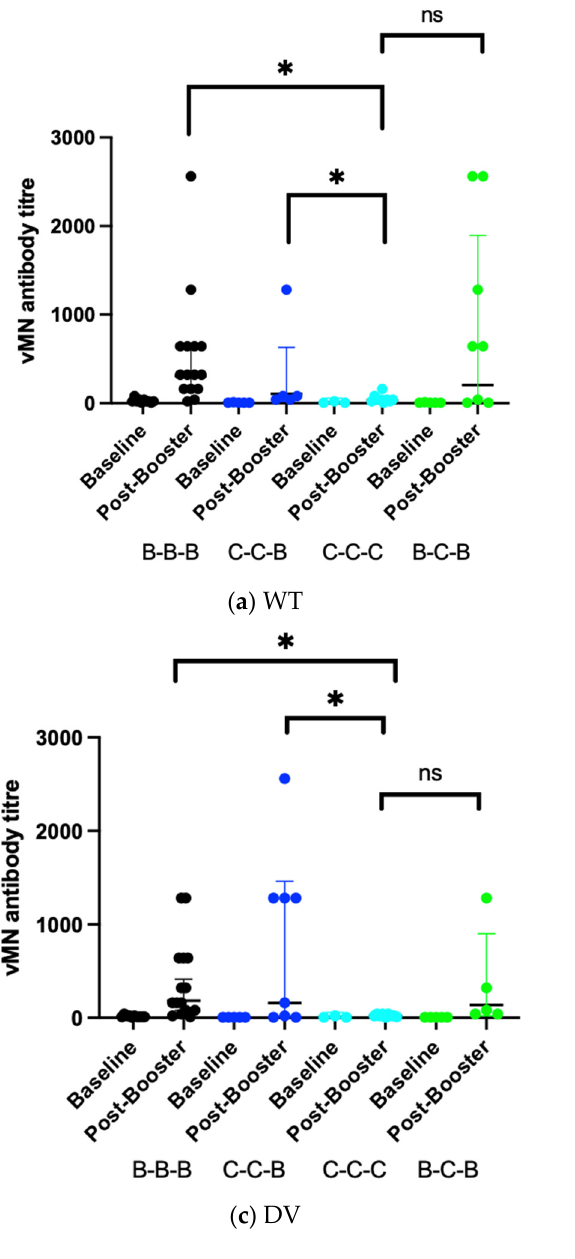
Figure 2. GMT titre of different vaccine combinations against SARS-CoV-2 variants at baseline and post booster vaccination. ( a ) Wild type; ( b ) Beta variant; ( c ) Delta variant; ( d ) Omicron variant; * = p < 0.05; ns = non-significant. Table 2. Immunogenicity of different vaccine platform.